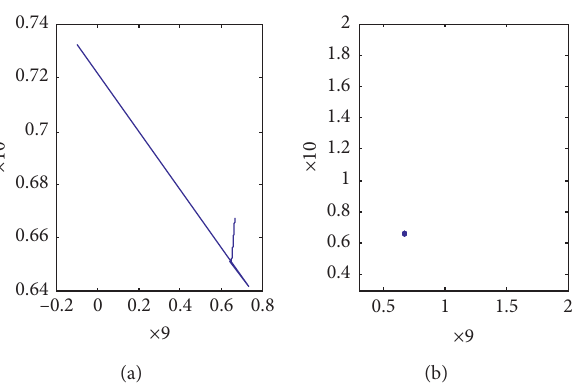
Figure 23: ω � 110 and k � 0 with the Coulomb model when w t ∈ 0 . 05 0 . 0581 􏼂 􏼃 . (a) Phase trajectories. (b) Poincare maps.